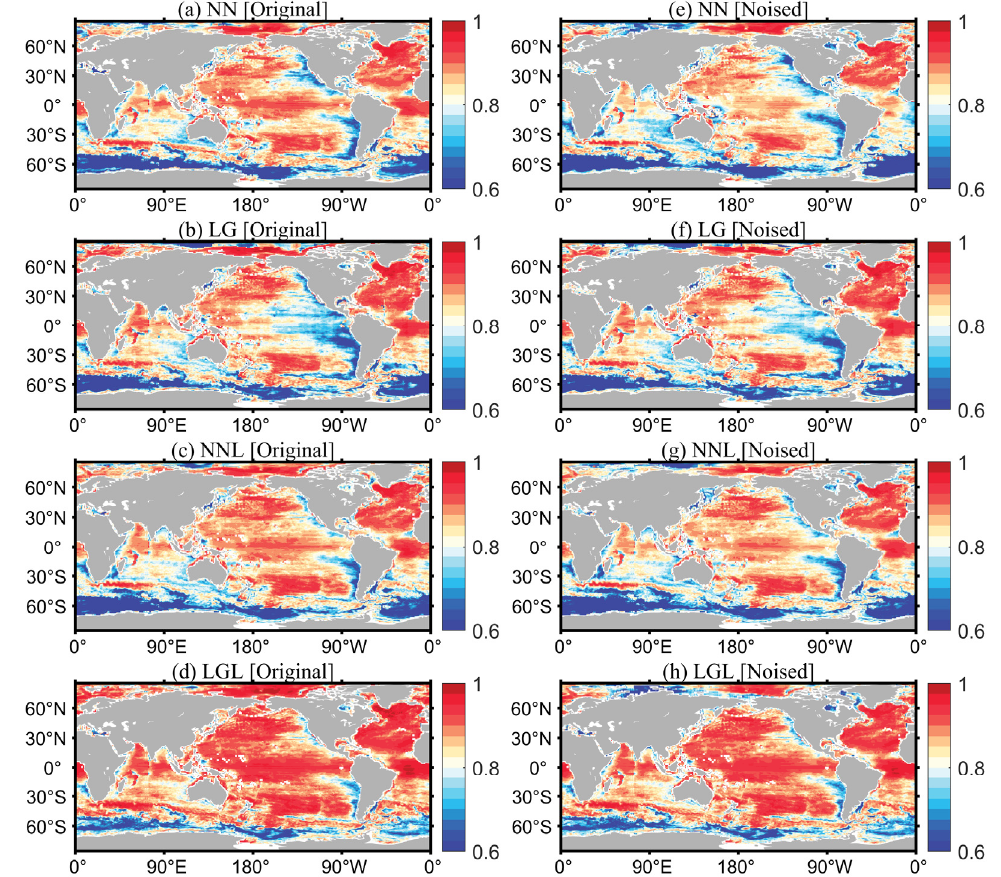
Figure 16. Spatial distributions of the average CCs in the 1–2000 m depth range of the four experi- ments. ( a – d ) Experiments performed with the original synthetic dataset. ( e – h ) Experiments performed with the noised synthetic dataset.